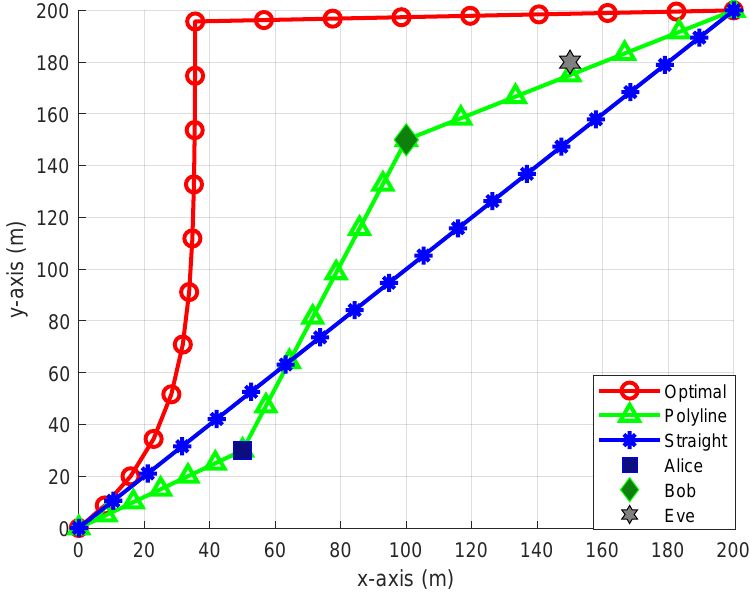
Figure 7. Three different AIRS trajectories in N = 20 time slots are given, including straight trajectory, polyline trajectory, and the designed optimal trajectory with P s = 100